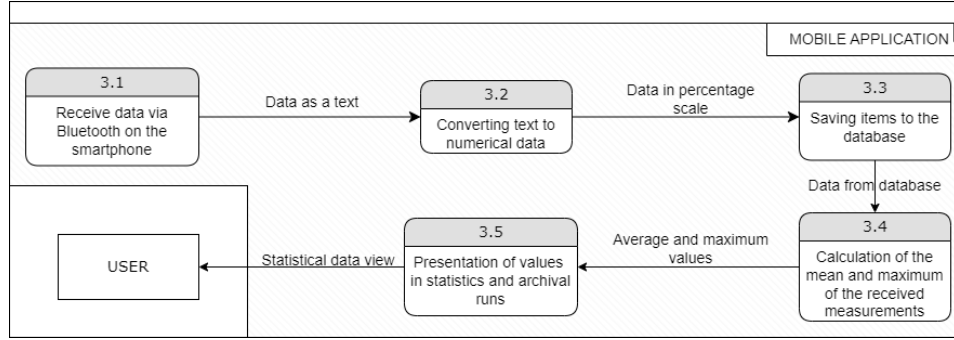
Figure 9. Data flow diagram—workout option.